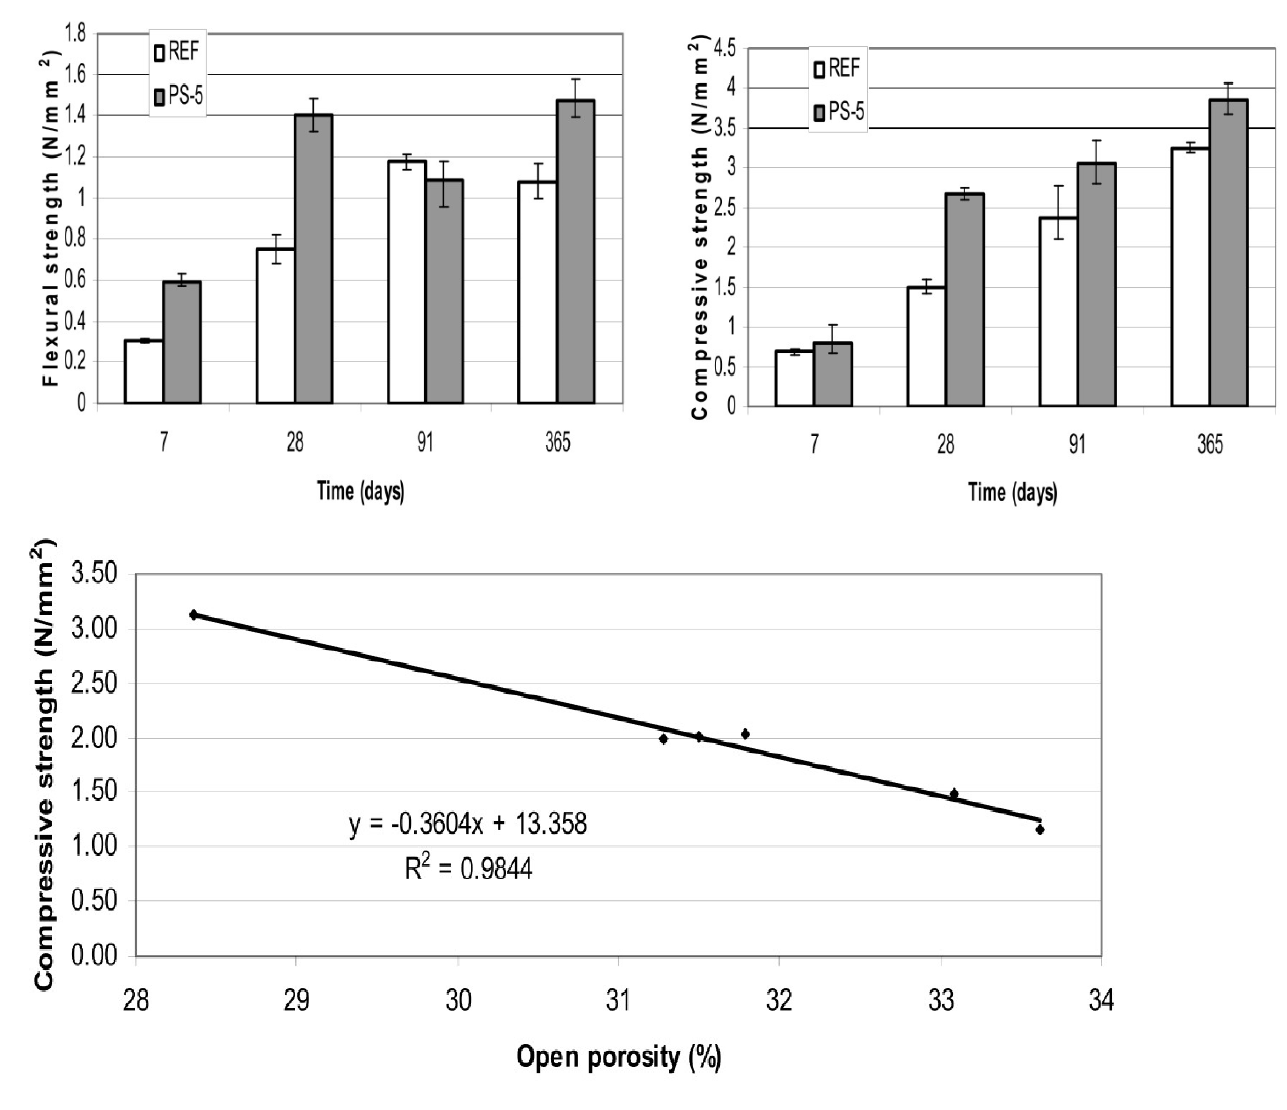
Figure 6. Test results from potato starch affect concrete properties (Izaguirre et